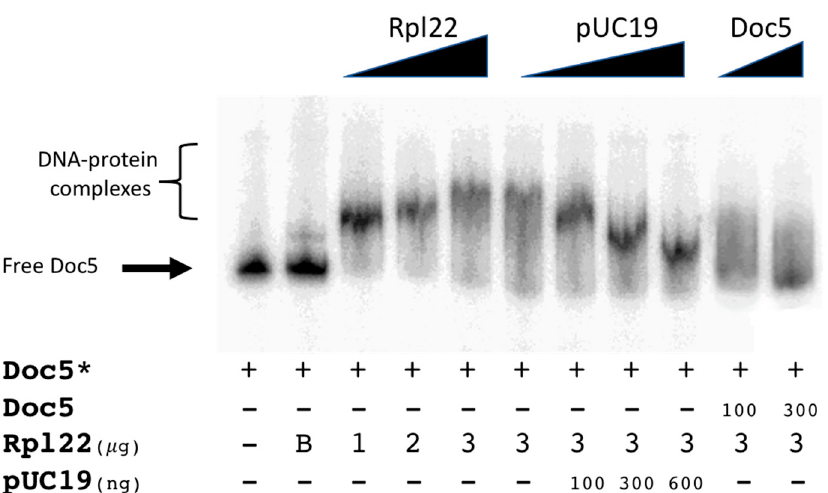
Figure 3. The binding of Rpl22 to Doc5 . The amount of labeled fragment (Doc5 *, Figure 3) in each lane is 3 ng. The amounts of unlabeled specific competitor (ng of Doc5), Rpl22 ( µ g), and unlabeled non-specific competitor (ng of linearized pUC19) are indicated in the figure legend under the respective lanes. Increasing amounts of purified Rpl22 protein (lanes 3–5) and non-specific (lanes 6–9) and specific (lanes 10–11) competitors are indicated on the top by triangles. A negative control (lane 2) was performed following the incubation of the Doc5-labeled probe with 3 μ g of non-induced E. coli (BL21 strain) lysate (indicated with B). The labeled fragments are indicated with an asterisk